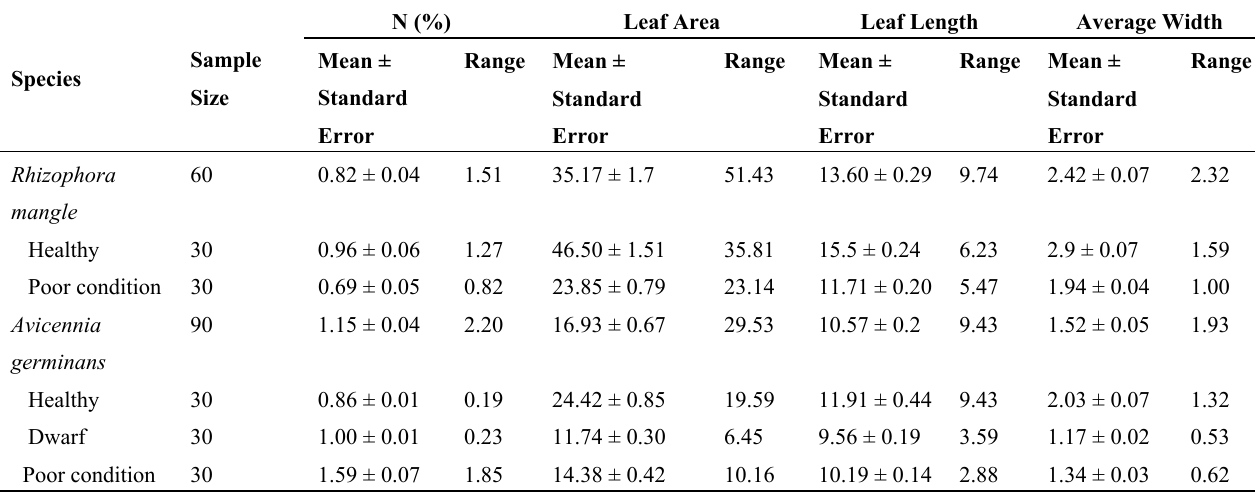
Table 1. Leaf N concentration and leaf size of Avicennia germinans and Rhizophora mangle in a lagoon near Mazatlan,